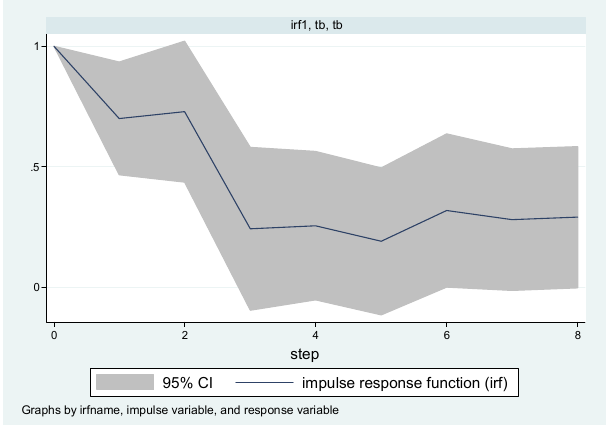
Fig. 2. The impulse response of the past "tb" variable to the current "tb" variable